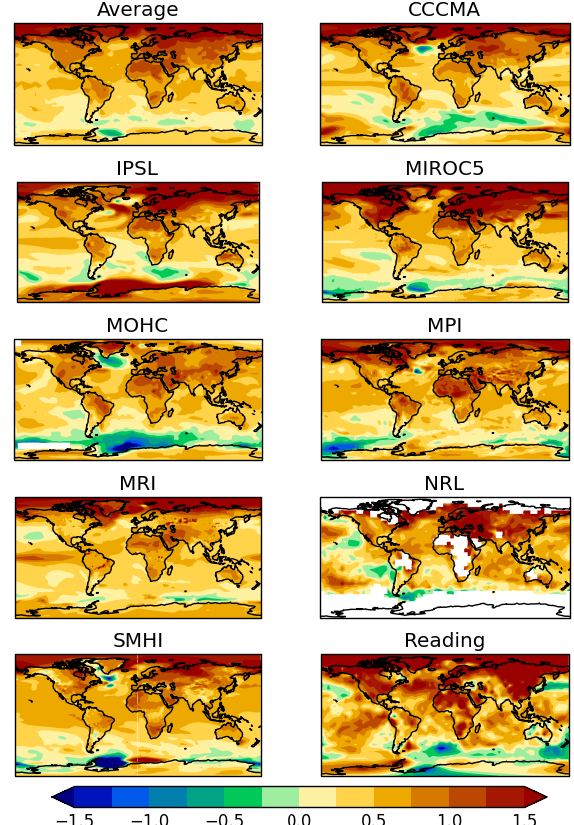
Figure 5. Example real-time multi-model decadal predictions (Smith et al., 2013a, available from http://www.metoffice. gov.uk/research/climate/seasonal-to-decadal/long-range/ decadal-multimodel). Maps show predicted near-surface tem- perature anomalies ( ◦ C) relative to the average over 1971 to 2000 for the 5-year period 2015–2019 from forecasts starting at the end of